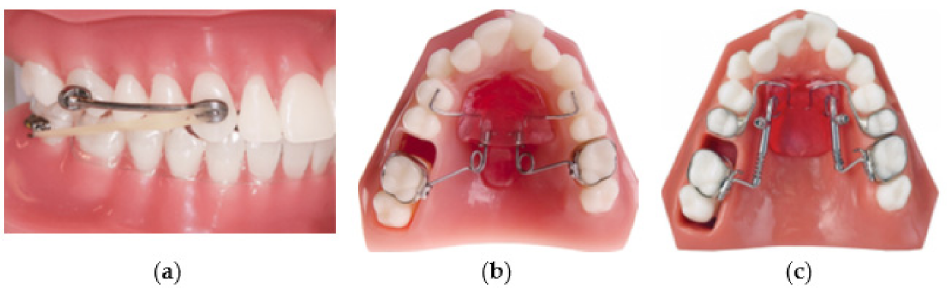
Figure 2. Examples of molar distalization appliances—distalizers ( a ) Carriere Motion 3D Appliance (CMA); ( b ) Pendulum appliance; ( c ) Distal Jet